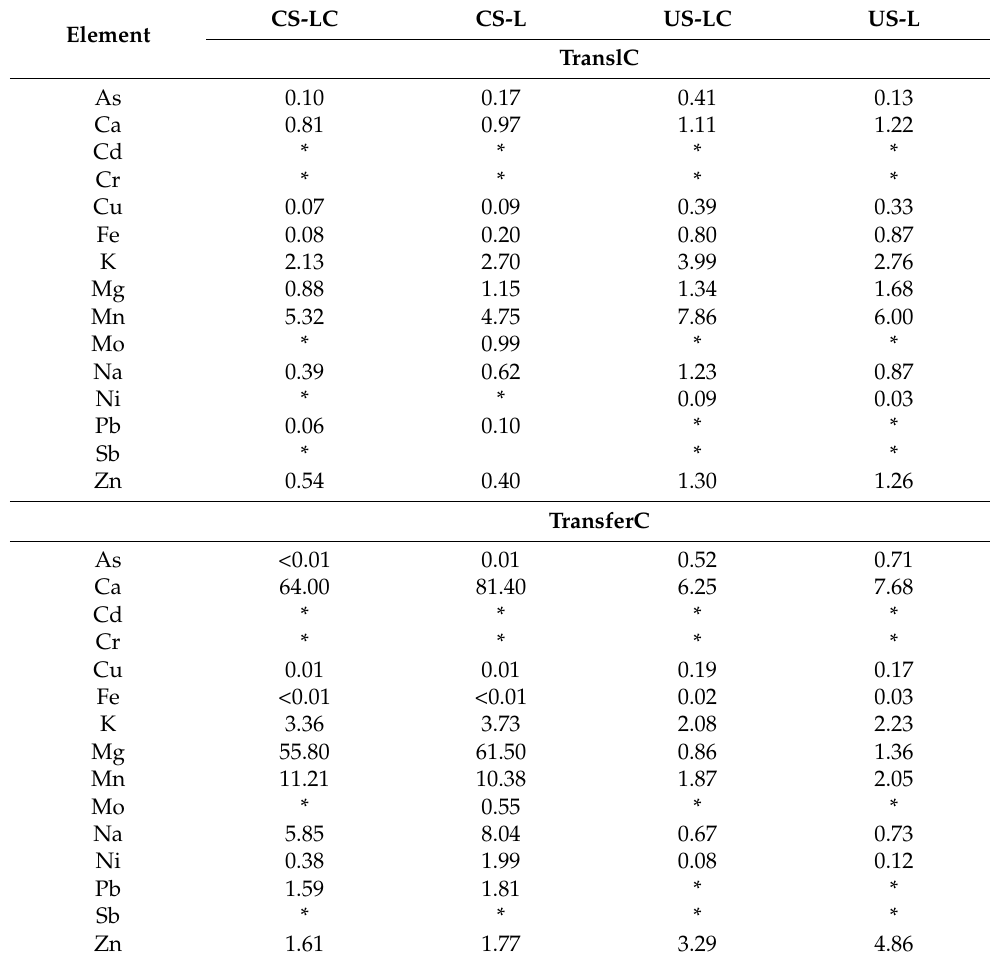
Table 3. Translocation coefficient (TranslC) and Soil-plant shoot transfer coefficient (TransferC) of metal(loid)s in L. pedunculata from S ã o Domingos (LC) and Caldeir ã o (L) growing in the contaminated soil from S ã o Domingos (CS) and the uncontaminated soil from Caldeir ã o (US) (values correspond to average; n = 4).